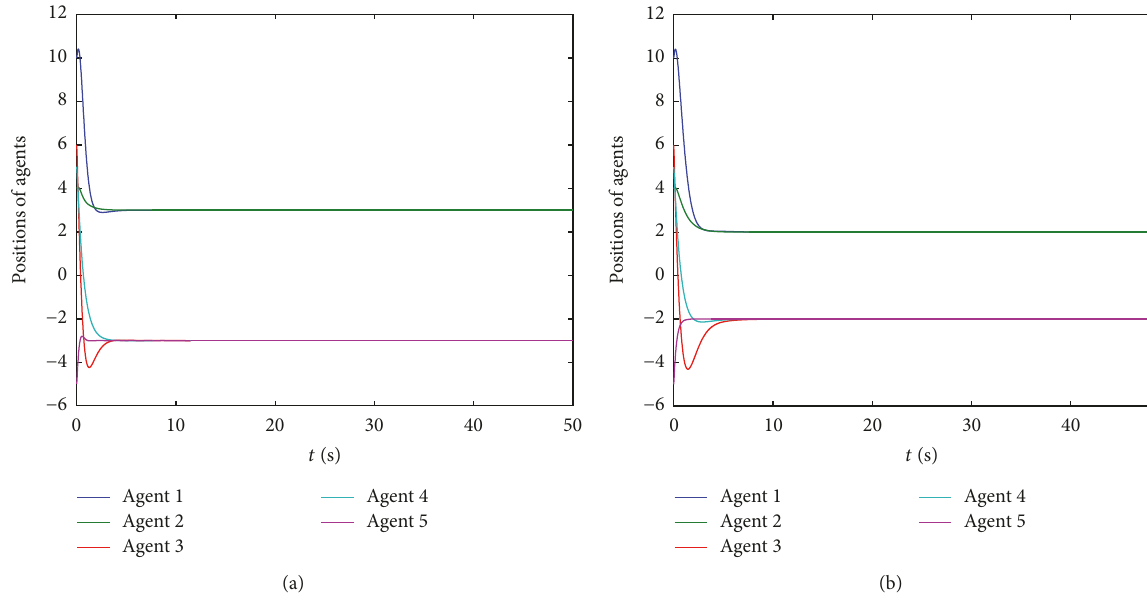
Figure 6: The state trajectories of the agents in systems (18). (a) 𝜏 = 0.1 s and (b) 𝜏 = 0.2 s.